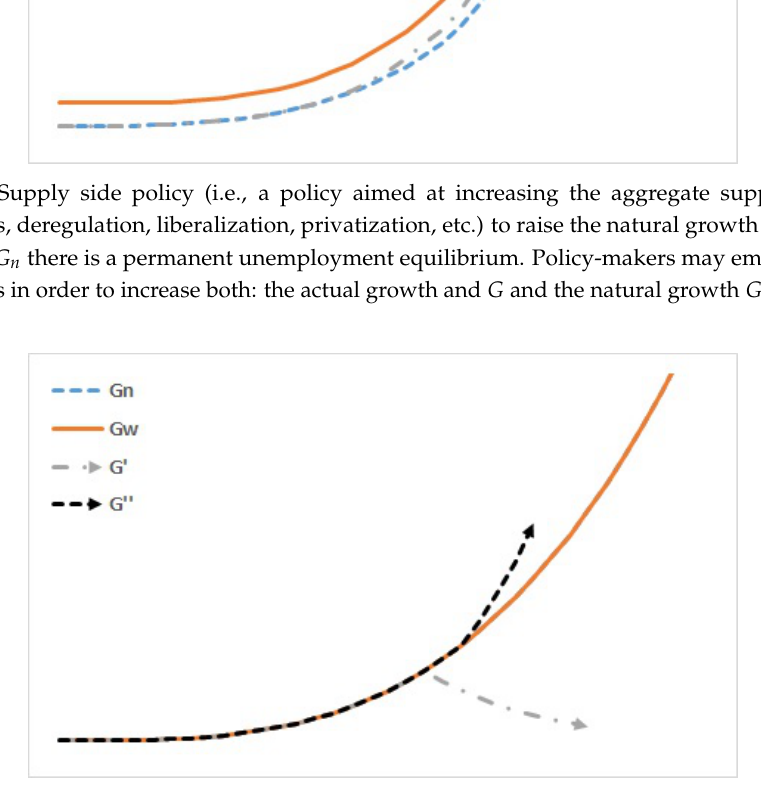
Figure 2. The Harrod knife-edge or unstable equilibrium. When G = G n = G w there is sustainable full employment. A departure from that may lead to recession ( G (cid:48) ) or booming periods ( G (cid:48)